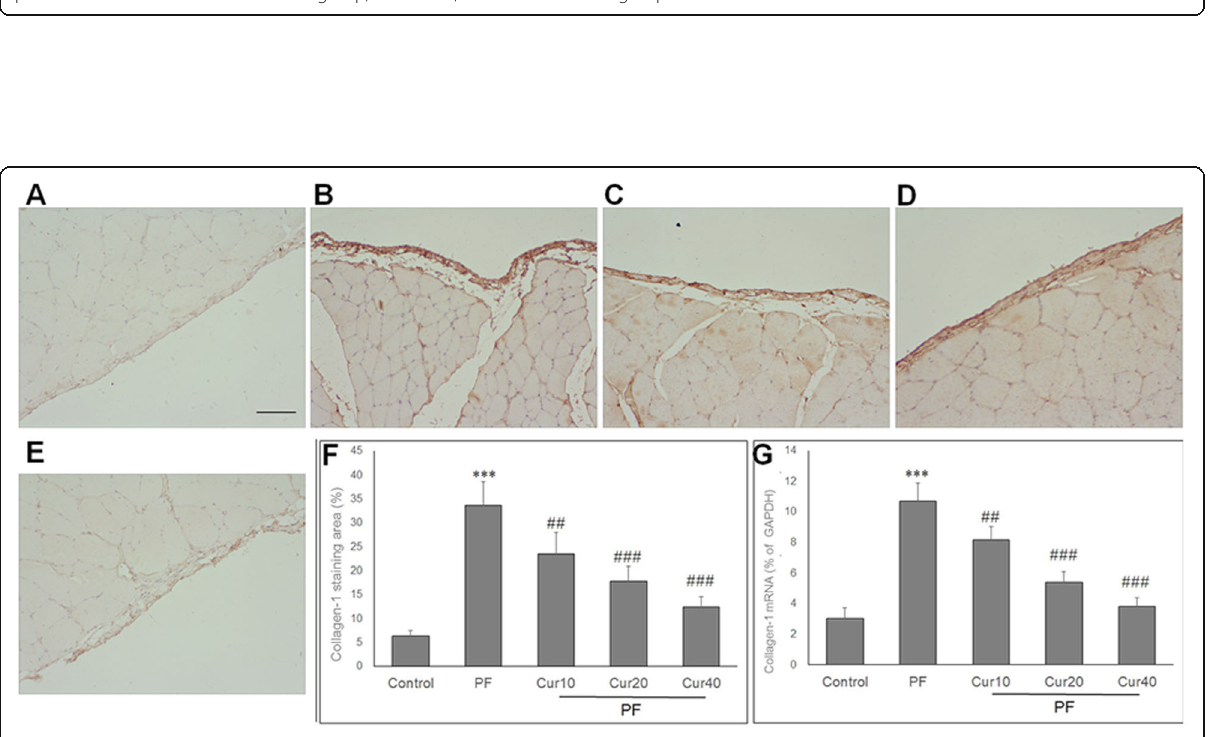
Fig. 5 Effect of curcumin on the expressions of collagen I in peritoneum of experimental PF model. Peritoneal expression of collagen I presented as staining area (%). Few collagen I were observed in the peritoneum of the control rats ( a ), but high collagen I expression were found in the PF rats ( b ). Curcumin at 10 mg/kg ( c ), 20 mg/kg ( d ) and 40 mg/kg ( e ) all markedly reduced the collagen I staining area. f Quantification analysis of the collagen I staining area in the peritoneum (%) in each group. g Quantitative real-time PCR showed the collagen I mRNA expression in the peritoneum of each group. ANOVA was performed and followed with Tukey ’ s post hoc test. *** P < 0.001 vs. control group; ## P < 0.01, ### P < 0.001 vs. PF group